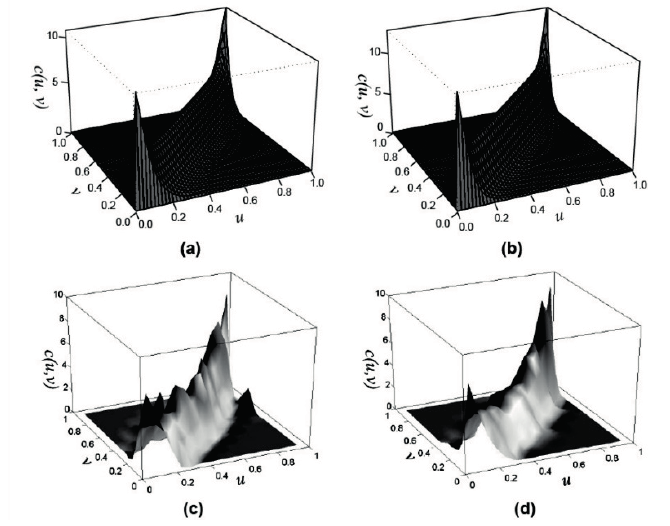
Fig. 2 Comparison of the POME-Frank copulas and empirical density distributions: (a) POME-Frank copula (S1-S2); (b) POME-Frank copula (S3-S4); (c) empirical density distribution (S1-S2); and (d) empirical density distribution